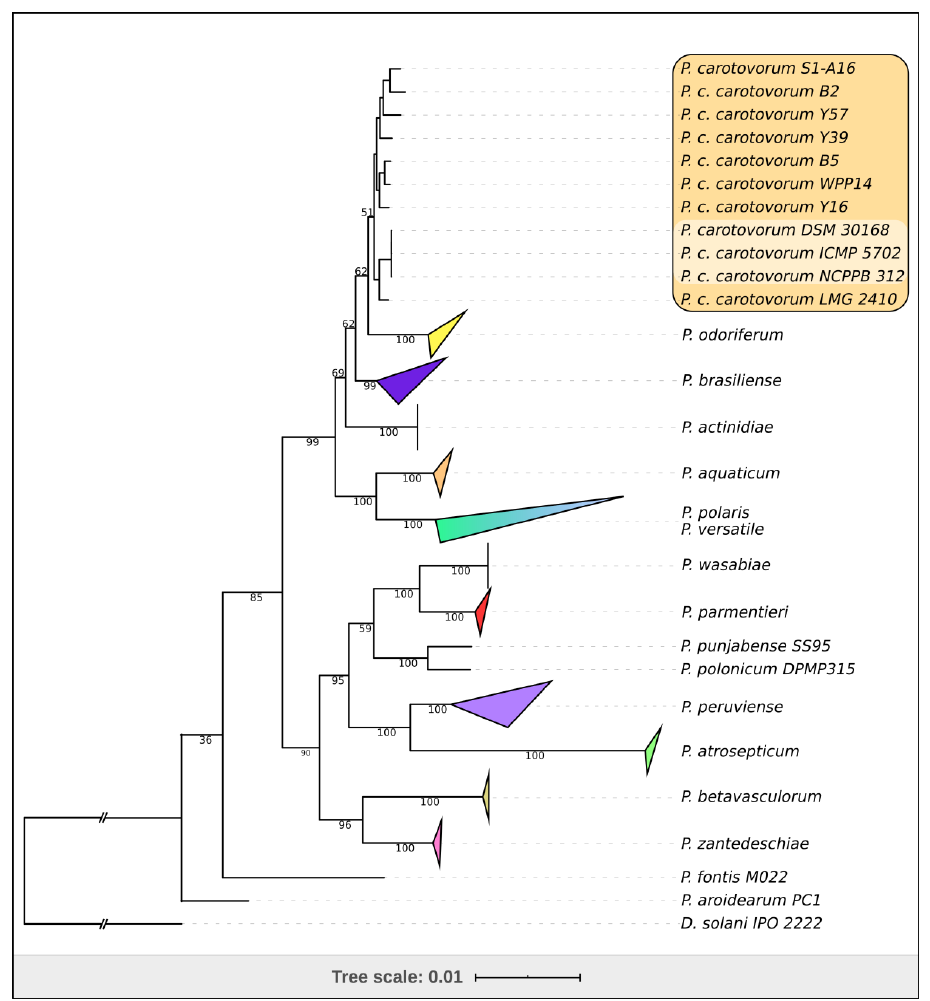
Figure 7. Phylogenetic tree of 147 concatenated amino sequences of 51 ribosomal proteins (RAxML,GAMMA I BLOSSUM62 protein model, with 1000 bootstrap replicates). Eleven Pectobacterium strains highlighted in bold form a monophyletic clade including the strain F160 ( P. carotovorum NCPPB 312 = ICMP 5702 = DSM 30,168 type strain). Dickeya solani IPO 2222 was used as an outgroup. The expanded branches are shown in Supplemental Figure 7.